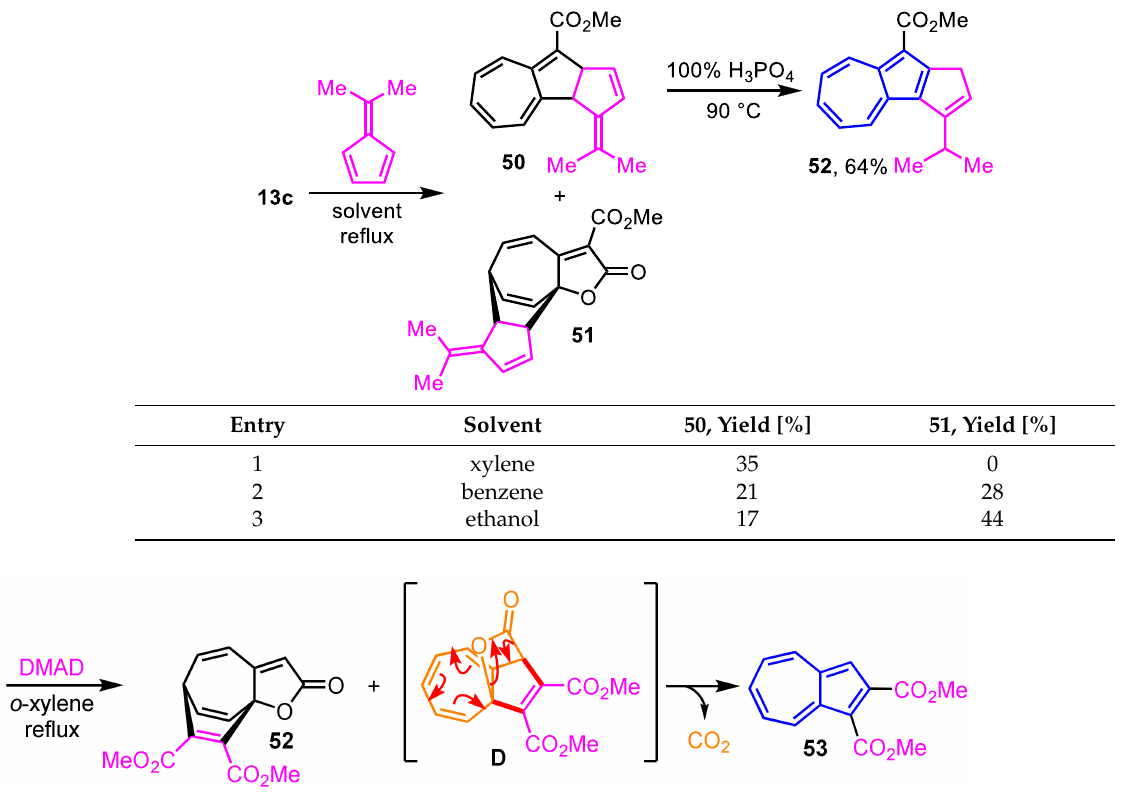
Table 2. The reaction of 13c with 6,6-dimethylfulvene.